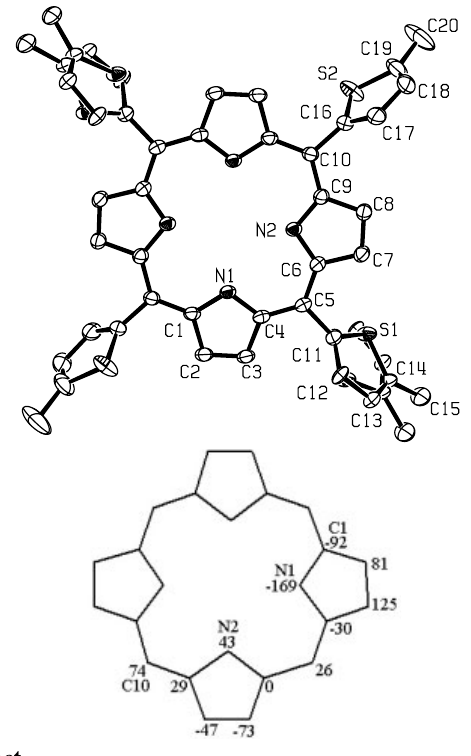
figure, bottom: deviations from mean plane in units of 0.001Å,